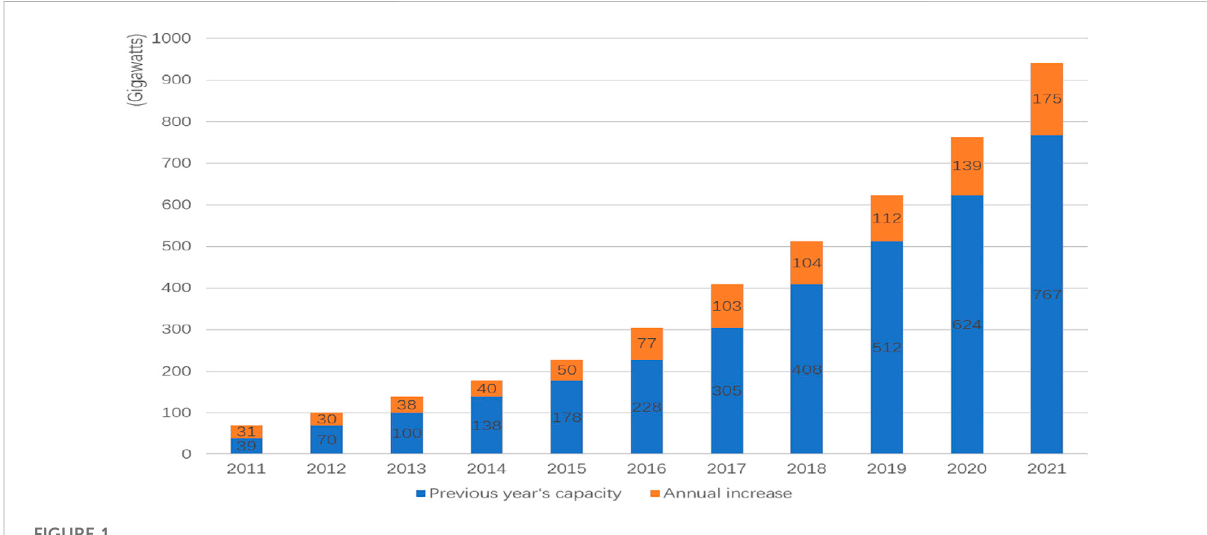
FIGURE 1 Solar PV global capacity and annual additions, 2011 –